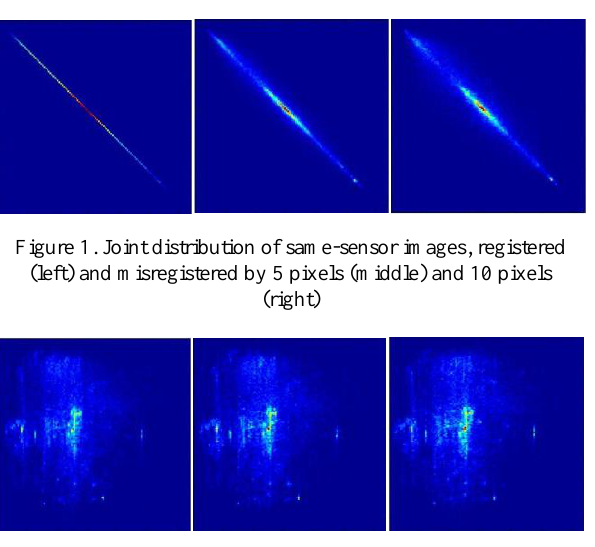
Figure 2. Joint distribution of multi-sensor images, registered (left) and misregistered by 10 pixels (middle) and 20 pixels